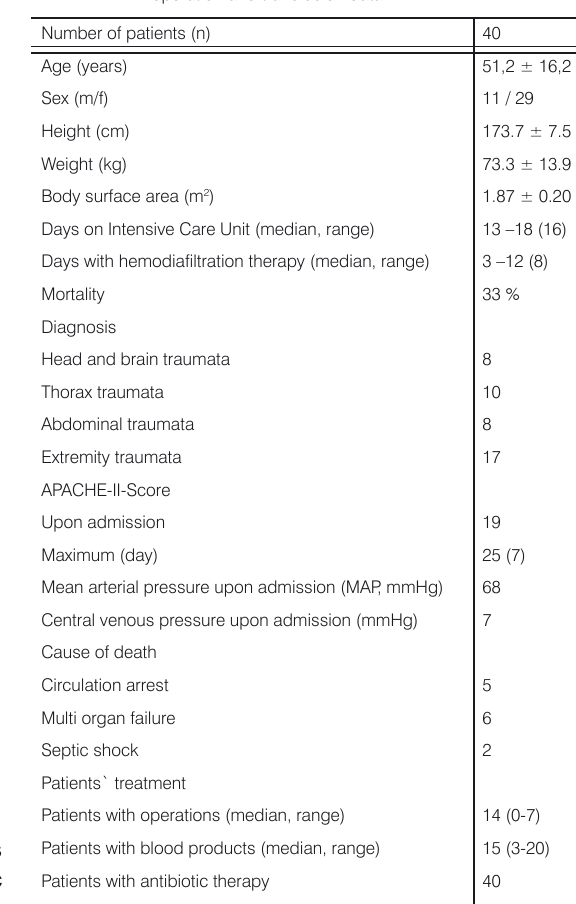
Figure 1. Diagram of time flow of all parameters until occurrence of